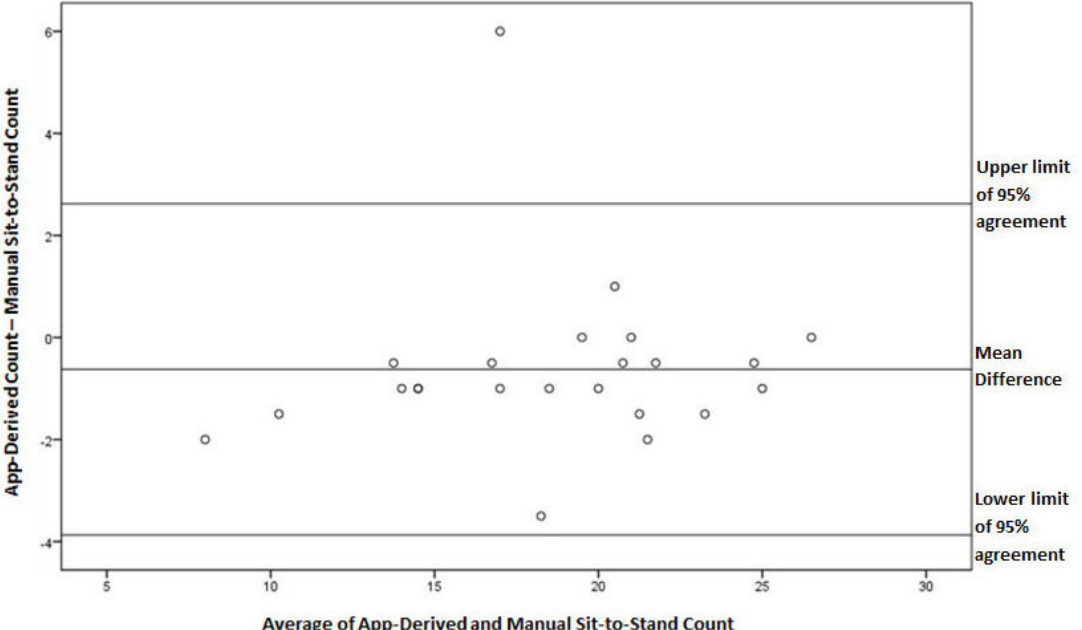
Figure 6. A Bland-Altman plot of differences between app-derived and manual sit-to-stand count during the 30-second Chair Stand Test. Line of mean difference is at -0.63 and upper and lower limits of 95% agreement are at 2.62 and -3.87,